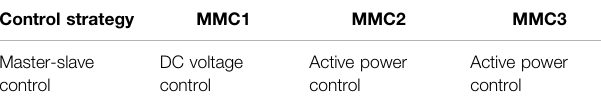
TABLE 2 | The typical control modes of MMC